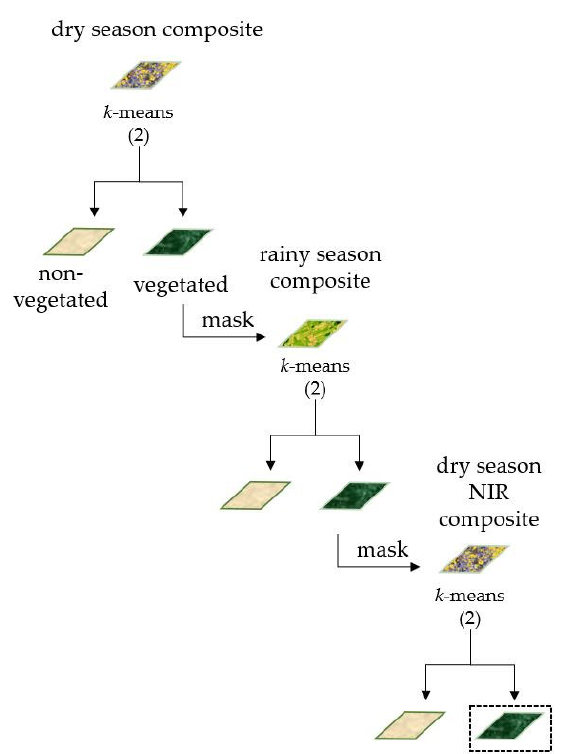
Figure 11. The three-step clustering and masking sequence that reduced commission errors with the dry season NIR band in a third masking step.